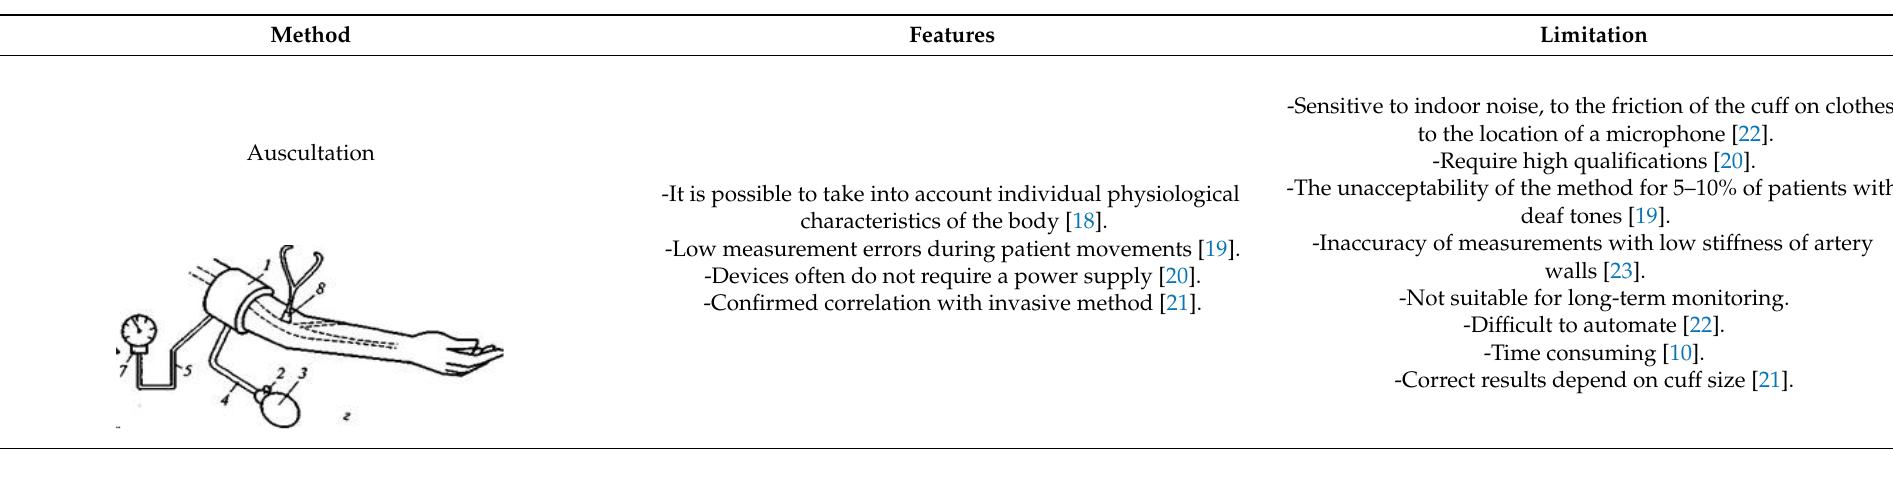
Table 1. Blood pressure estimation techniques.